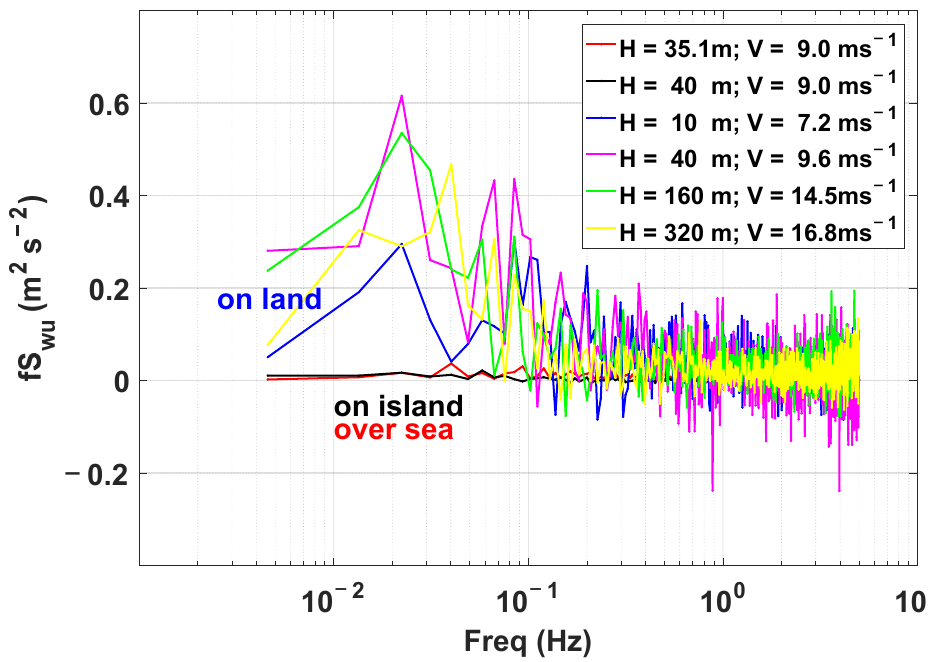
Figure 7. The same as Figure 6 except for cospectra of along-wind momentum flux.